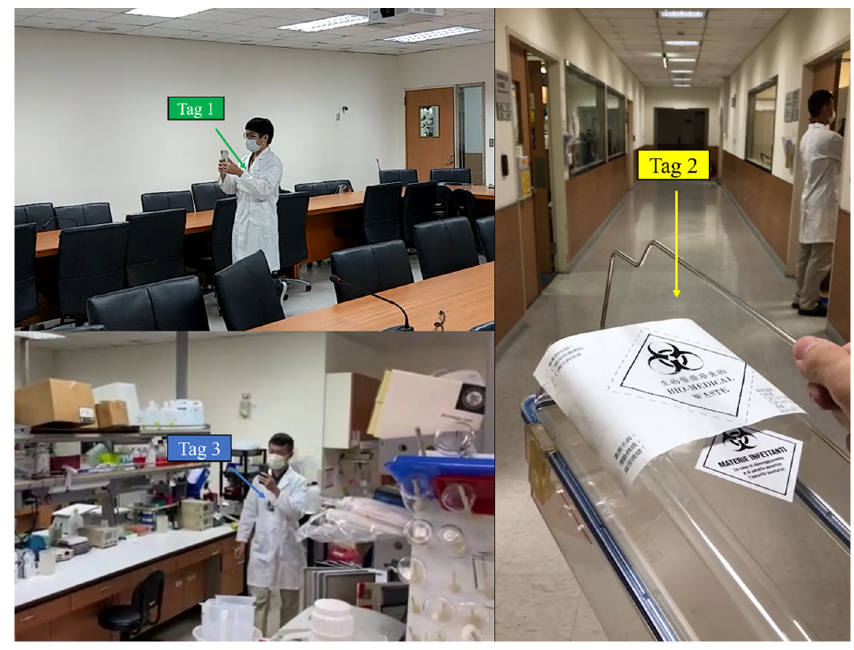
Figure 22. The tags in the experiment.